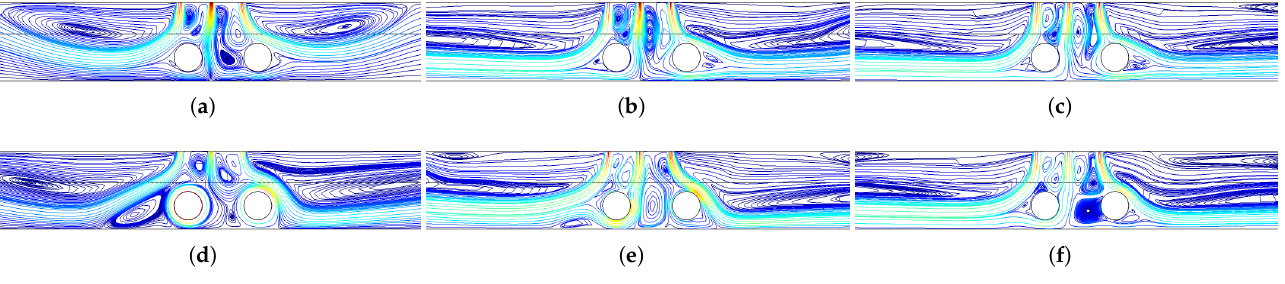
Figure 3. Impacts of Re on streamline variations at two different rotational speeds of the hot cylinders (sc = 3Rc, Da = 0.01, HNF-2%). ( a ) Re = 100, Rew = 0; ( b ) Re = 300, Rew = 0; ( c ) Re = 500, Rew = 0; ( d ) Re = 100, Rew = − 500; ( e ) Re = 300, Rew = − 500; ( f ) Re = 500, Rew = −